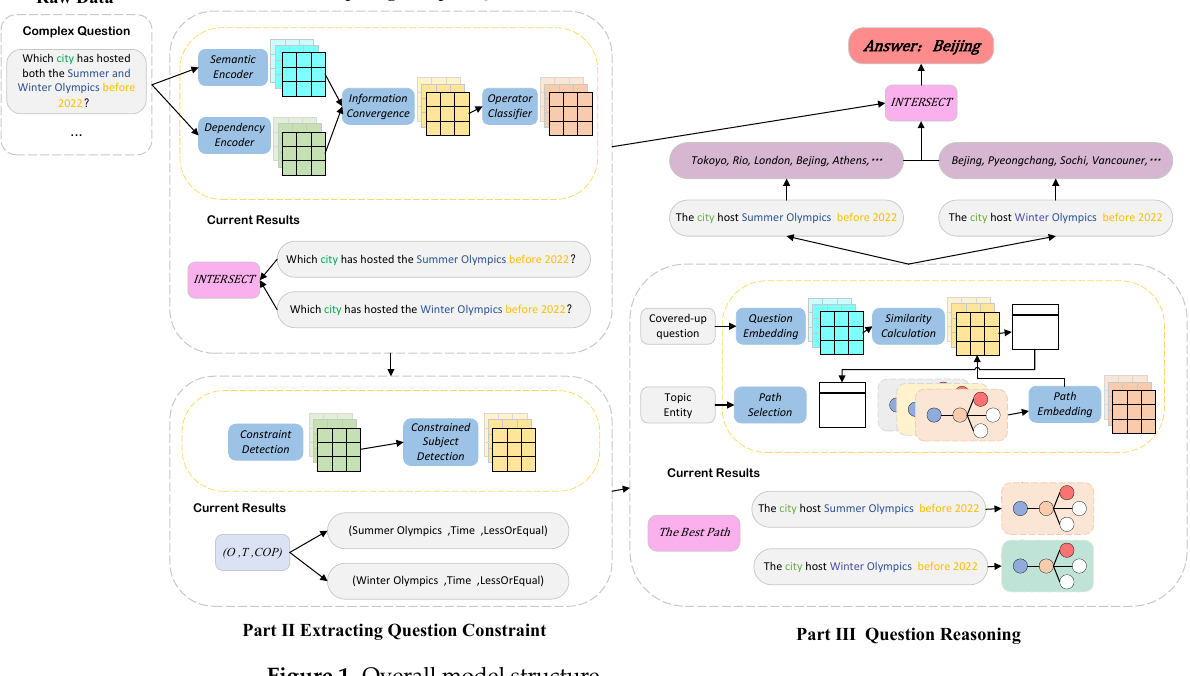
Figure 1. Overall model